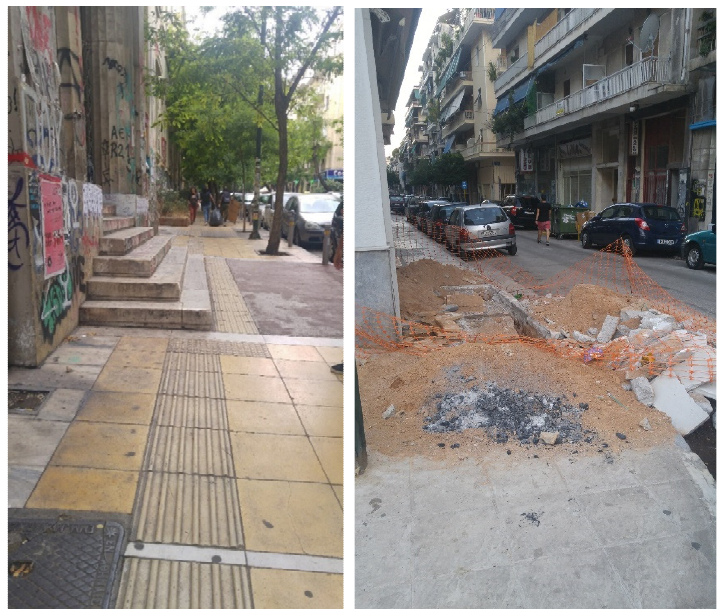
Figure 10. Not detected